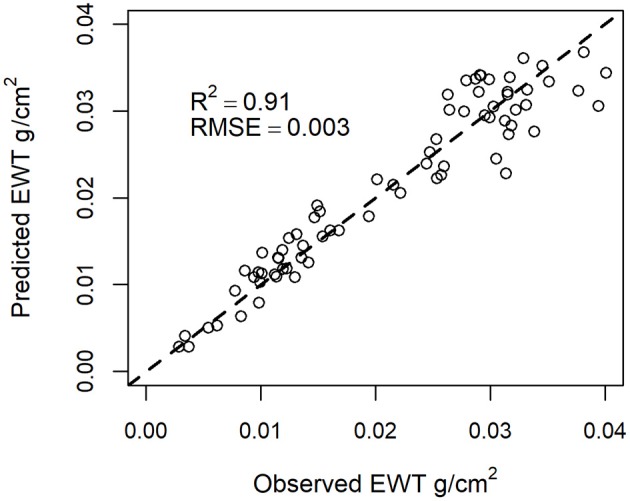
EWT estimation using NDI_p70905, 1,550 and length of the seedling as predictors.